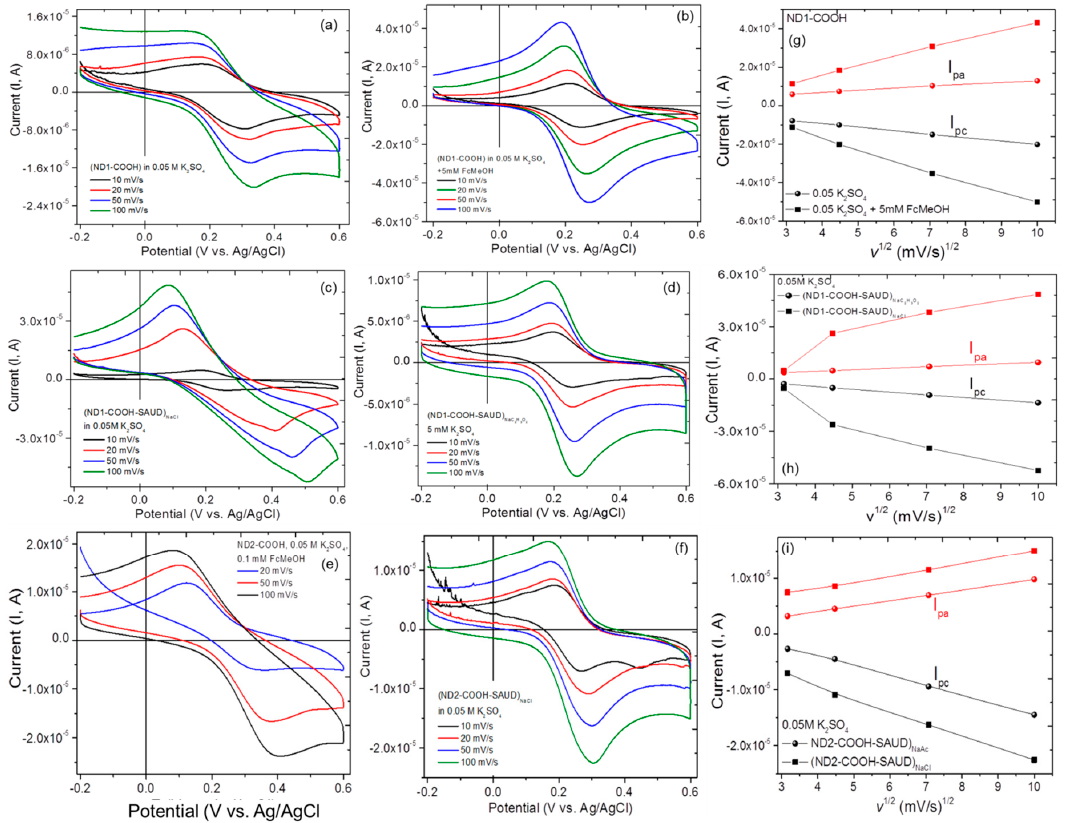
Figure 5. ( a – f ) Cyclic voltammograms of annealed nanodiamond (ND1–COOH and